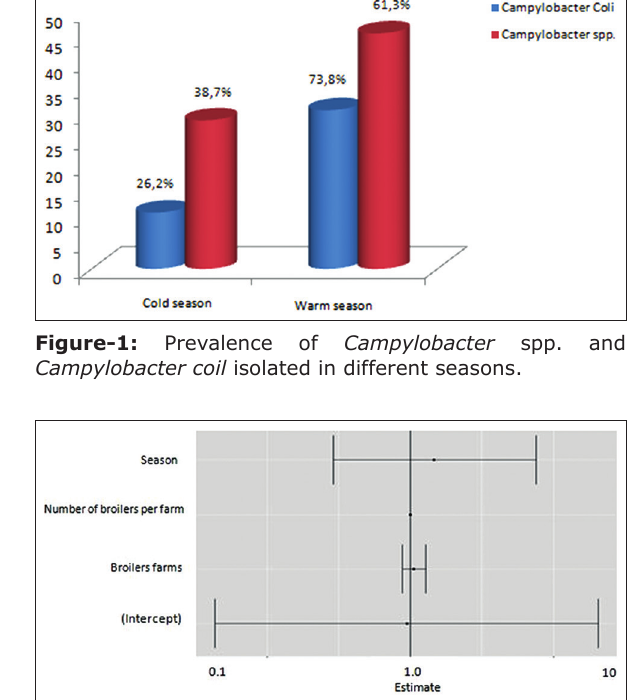
Figure-2: Odds ratios for the three predictors: Season, broiler farms, and number of broilers. Table-1: Results of logistic regression modeling with odds ratios.